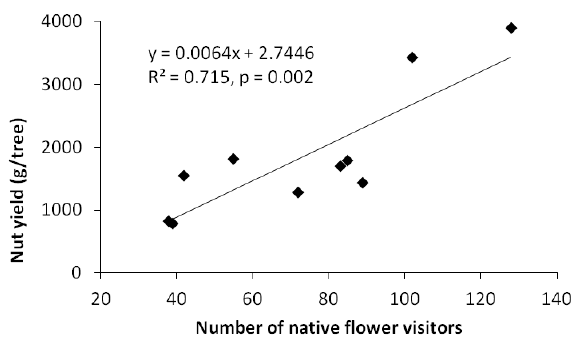
F IGURE 5. Effect of the number of flower visits by native pollinators on cashew ( Anacardium occidentale ) nut yield (g/tree) in ten plantations of the state of Ceará,